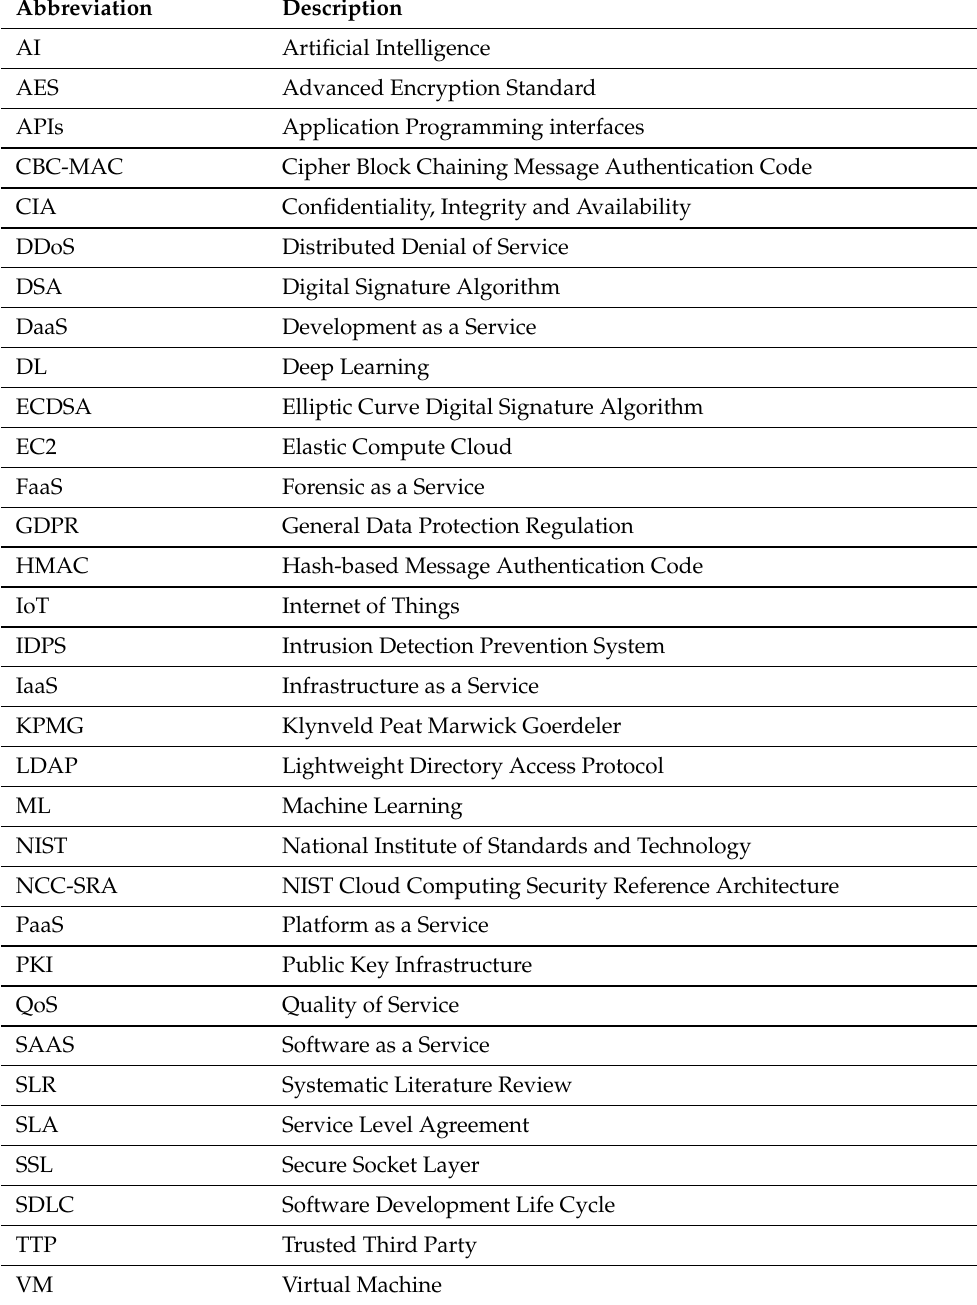
Table 1. List of